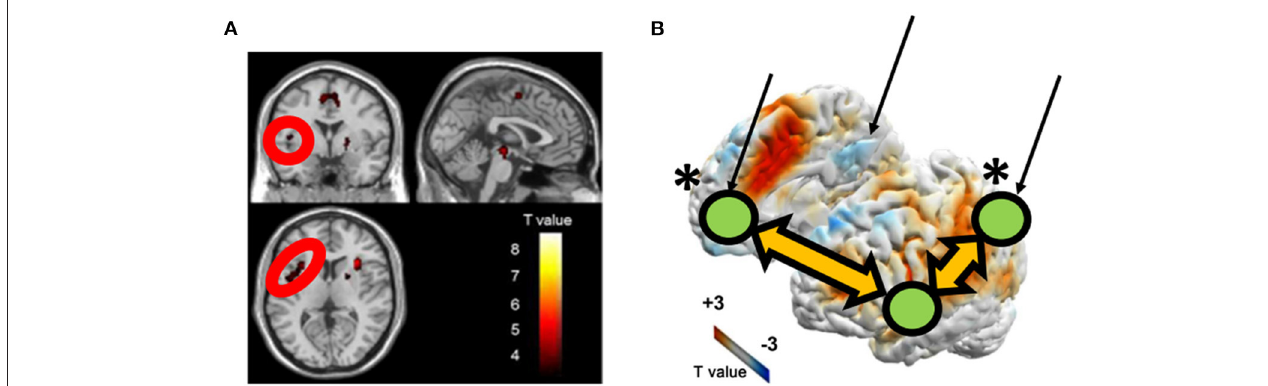
FIGURE 9 | Brain activity (A) and functional connectivity (B) are associated with the duration of illness in patients with gambling disorder. (A,B) is revised from Tsurumi et al. (77) and Tsurumi et al. (83), respectively. The arrows indicate the locations of DMN regions. The *indicates a between-group difference regarding the insular seed and marked DMN nodes.